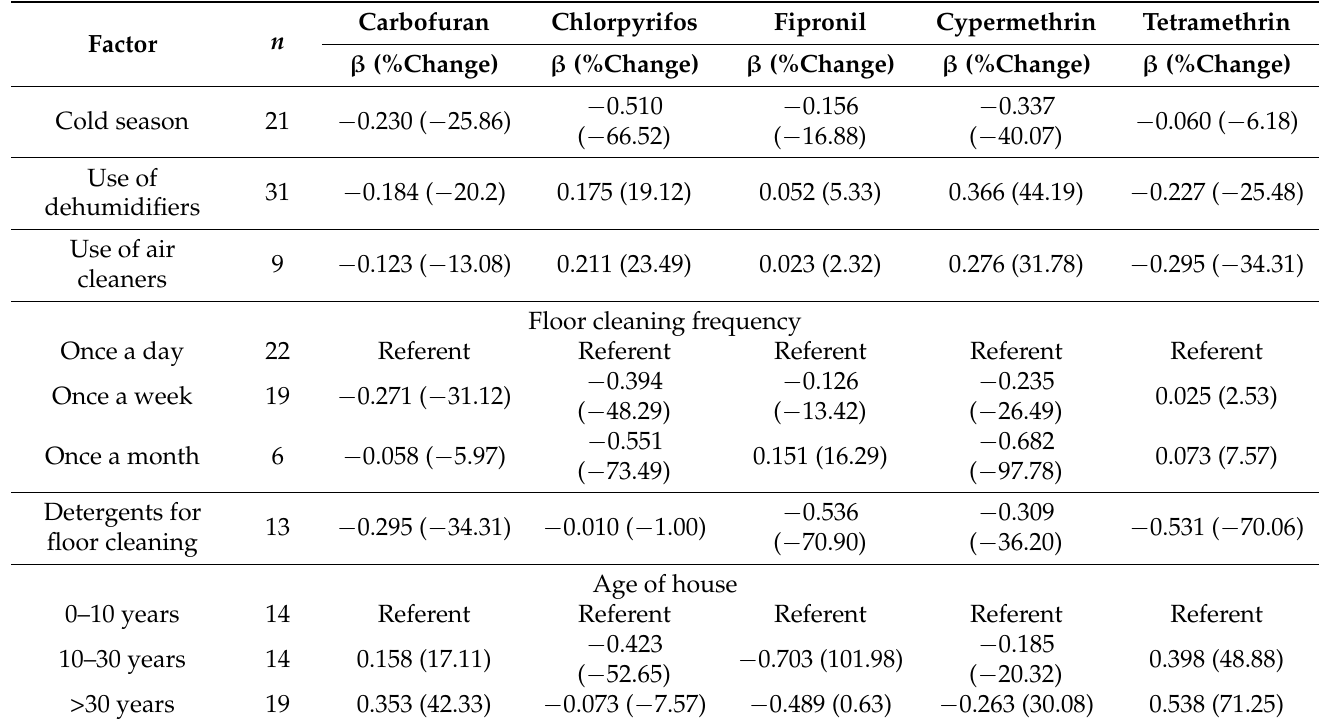
Table 2. Associations between indoor pesticide concentrations and questionnaire responses by univariate linear regression analysis ( n =